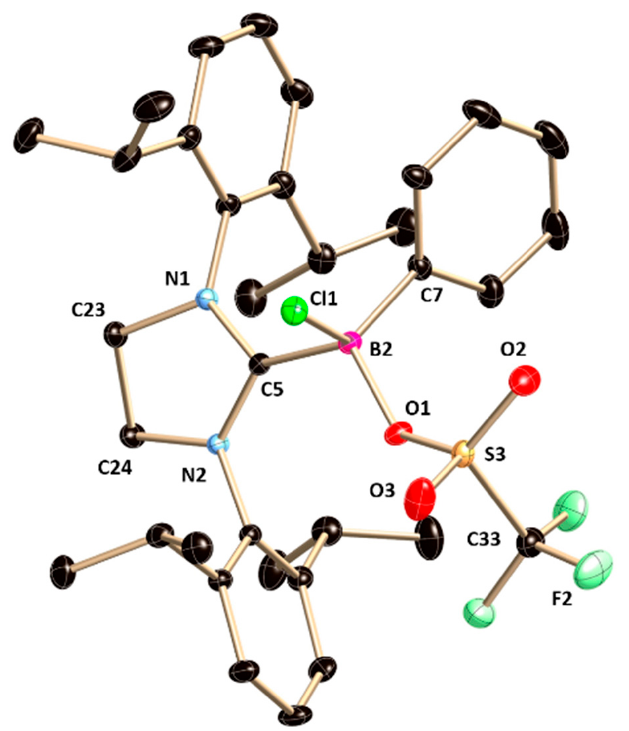
Figure 5. The molecular structure of 5a . Hydrogen atoms are omitted for clarity. Selected bond lengths [Å] or angles [deg]: N1–C5 1.341(2), N2–C5 1.330(2), C23–N1 1.485(2), C24–N2 1.482(2), C5–